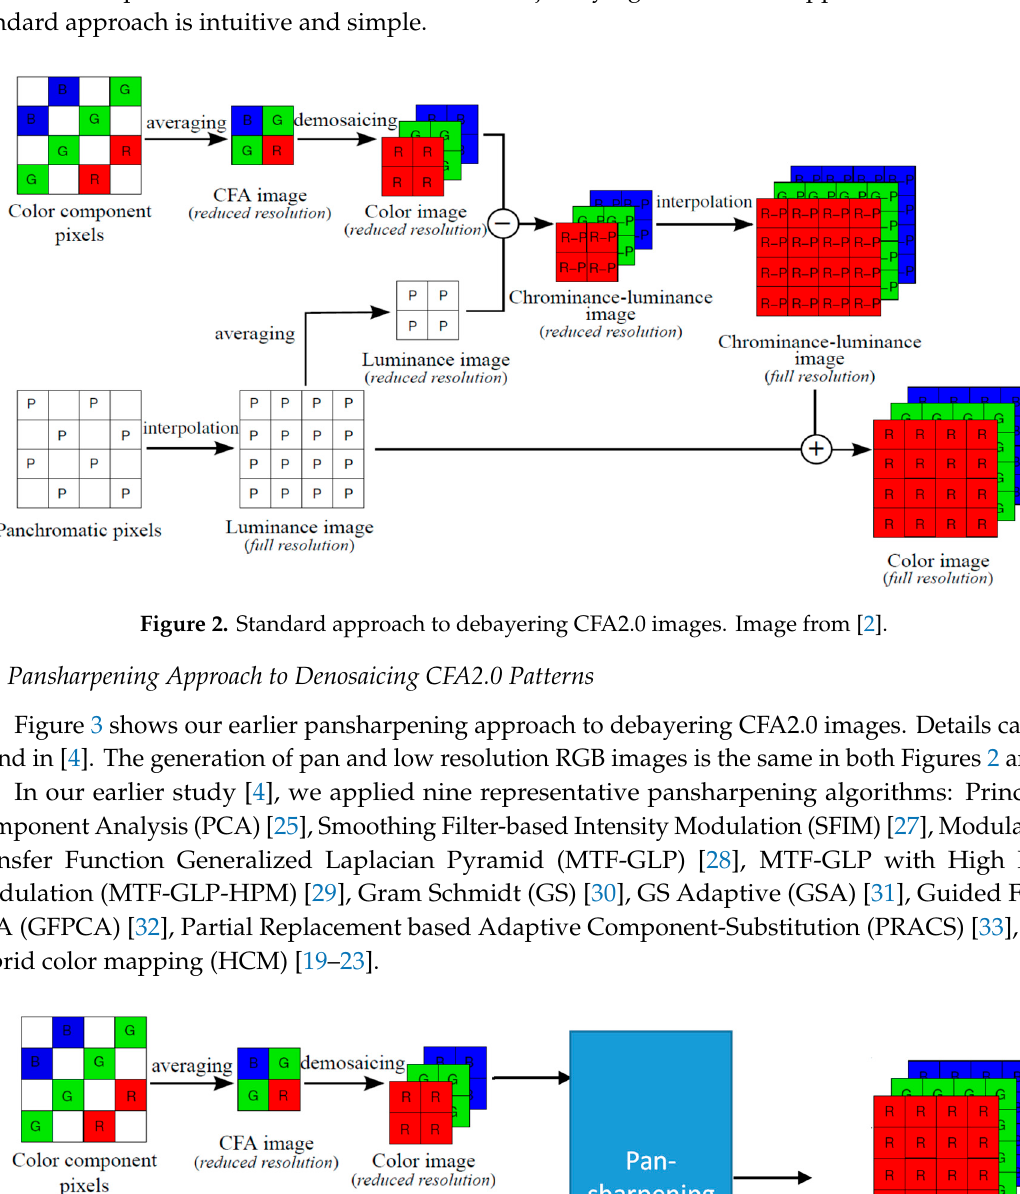
Figure 2. Standard approach to debayering CFA2.0 images. Image from [2].